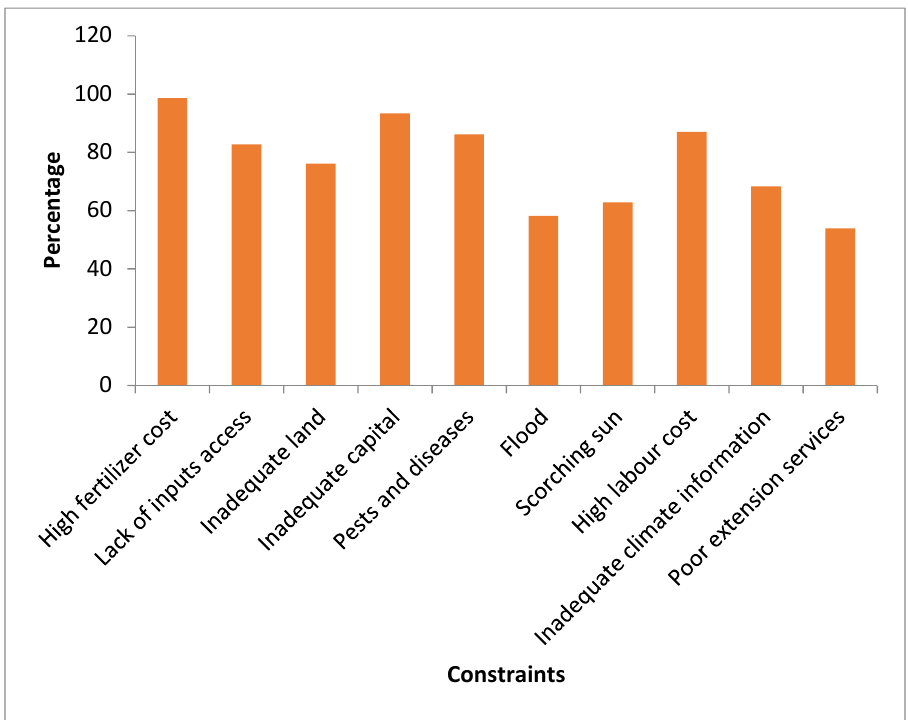
Figure 3. Constraints to adoption of climate-smart agricultural practices/technologies in rice pro- duction.